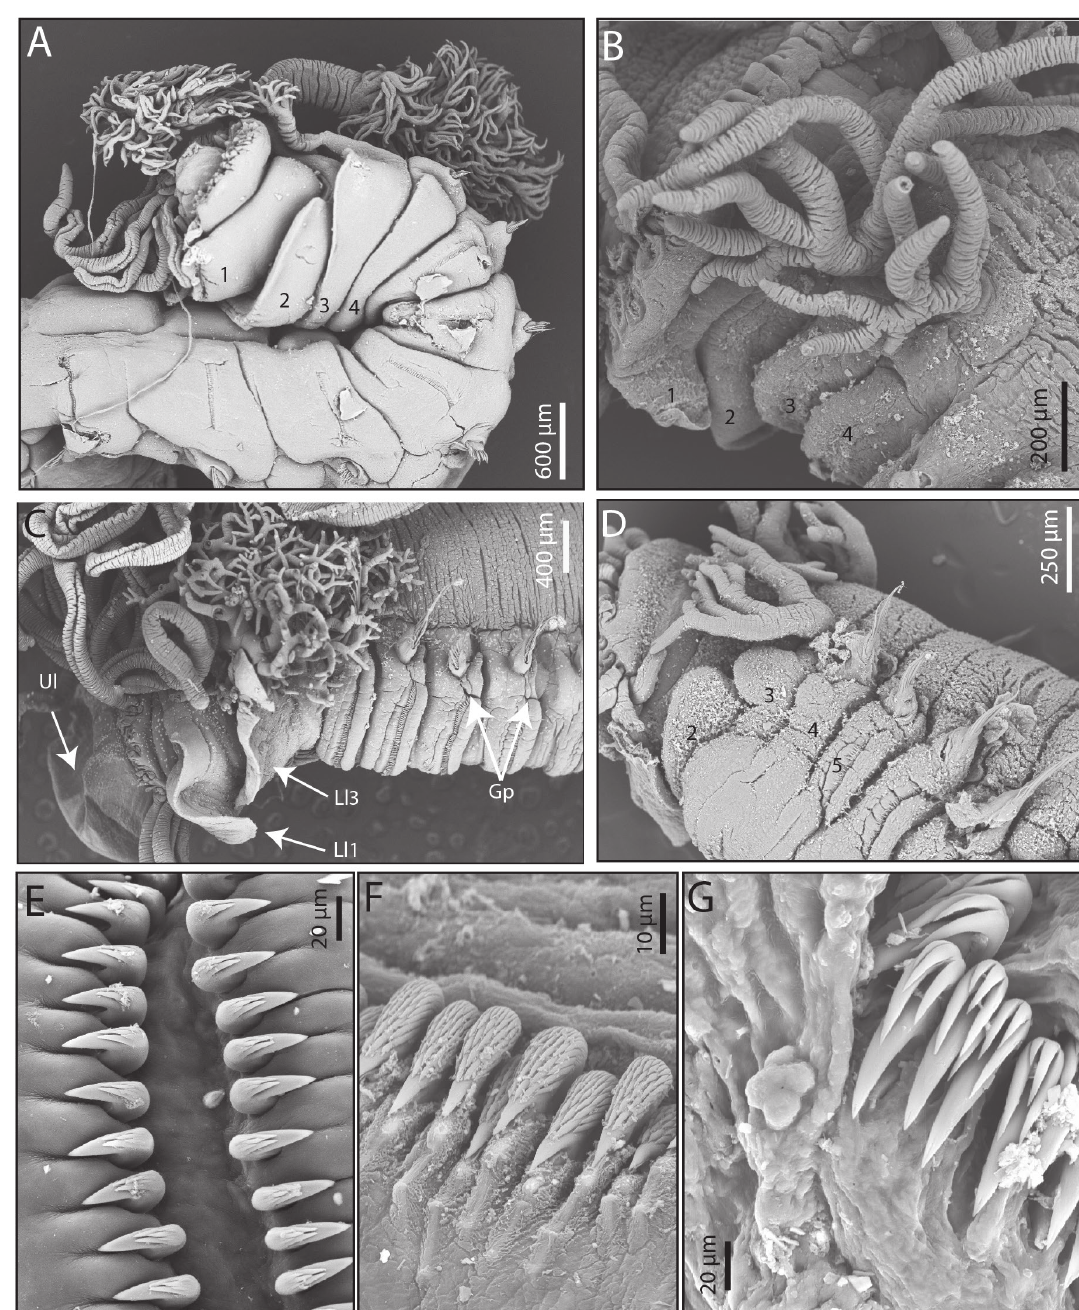
Fig. 6. Diversity of Terebellidae Johnston, 1846 (s.s . ) , SEM. A . Pista sauriaui Lavesque, Daffe, Londoño- Mesa & Hutchings, 2021, anterior end, lateral view (paratype MNHN-IA-TYPE 2036). B . Paramphitrite dragovabeci Lavesque, Daffe, Londoño-Mesa & Hutchings, 2021, anterior end, lateral view (paratype MNHN-IA-TYPE 2030). C . Lanice kellyslateri Lavesque, Daffe, Londoño-Mesa & Hutchings, 2021 , anterior end, lateral view ( paratype MNHN-IA-TYPE 2028). D . Eupolymnia meissnerae Lavesque, Daffe, Londoño-Mesa & Hutchings, 2021 , anterior end, ventro-lateral view (paratype MNHN-IA-TYPE 2025). E . Lanice kellyslateri, thoracic uncini ( paratype MNHN-IA-TYPE 2028). F . Paramphitrite dragovabeci , uncini SG XIV (paratype MNHN-IA-TYPE 2030). G . Eupolymnia meissnerae, uncini SG VIII (paratype MNHN-IA-TYPE 2025). Abbreviations: Gp = genital papillae; Ll = lateral lobes; Ul = upper lip. Numbers referring to